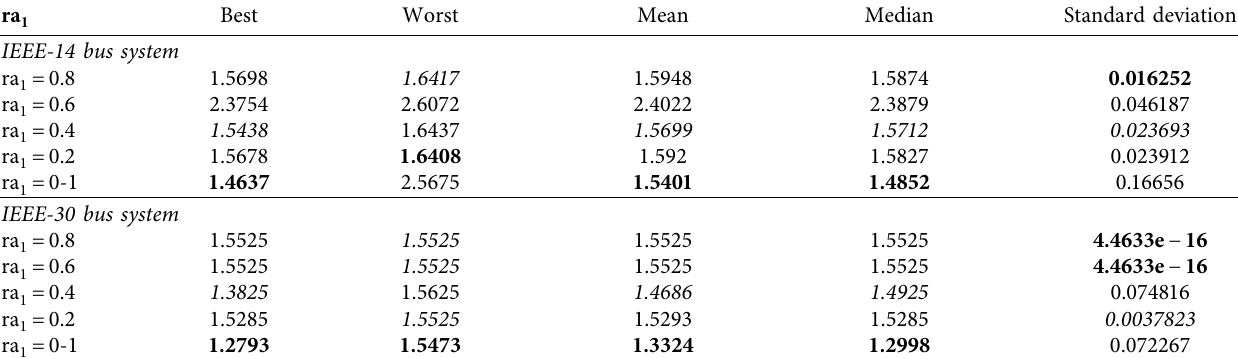
Bold values are used to show the performance of diferent methods after statistical analysis Table 11: Statistical evaluation of the proposed POCSO algorithm at various arbitrary values for optimal power generation IEEE-14 bus system.